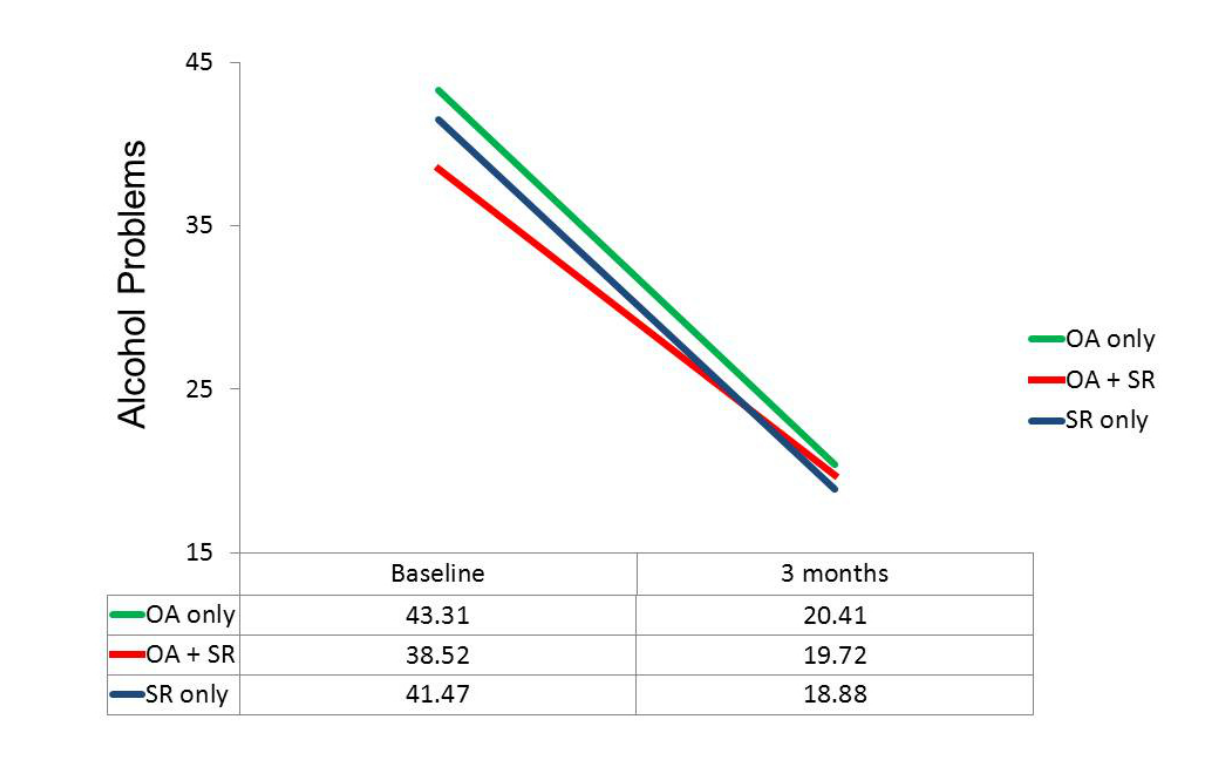
Figure 5. Actual use groups: Alcohol-related problems.